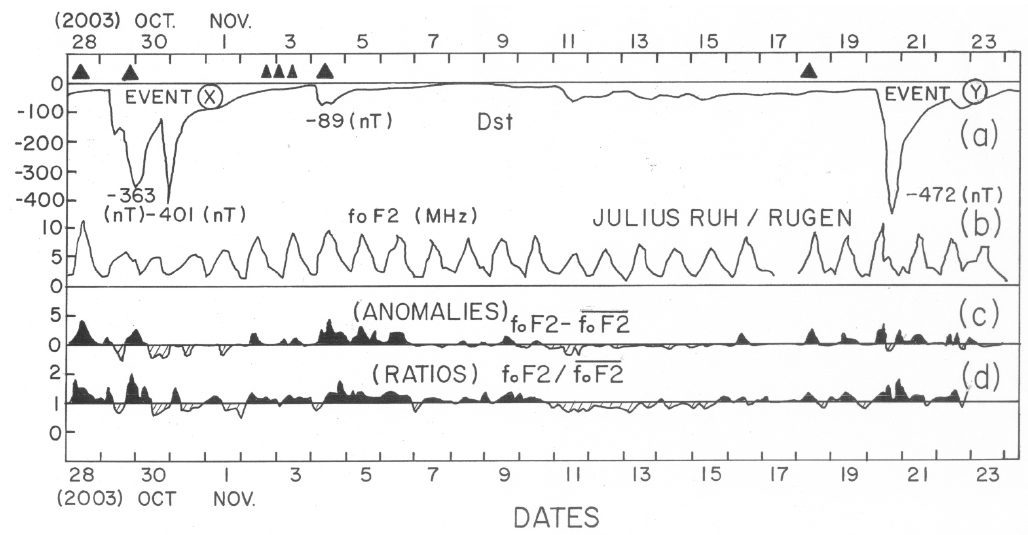
Fig. 1. Plots for the 27-d interval 28 October–23 November 2003 of the hourly values of (a) geomagnetic D st , (b) ionospheric f o F2 at the midlatitude European location Juliusruh/R¨ugen (54.6 ◦ N, 13.4 ◦ E), (c) f o F2 anomalies, (d) f o F2 ratios. Positive deviations and ratios above 1.0 are painted black, negative deviations and ratios below 1.0 are shown as hatched. The triangles indicate solar flare